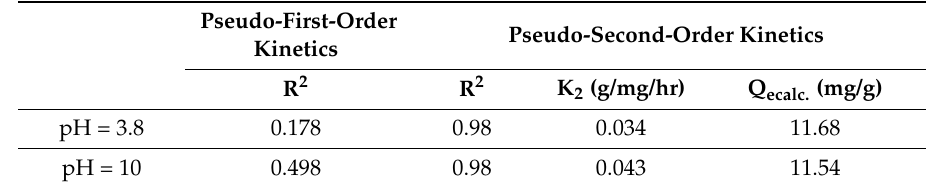
Table 4. Kinetics of iron(II) adsorption on the surface of composites.